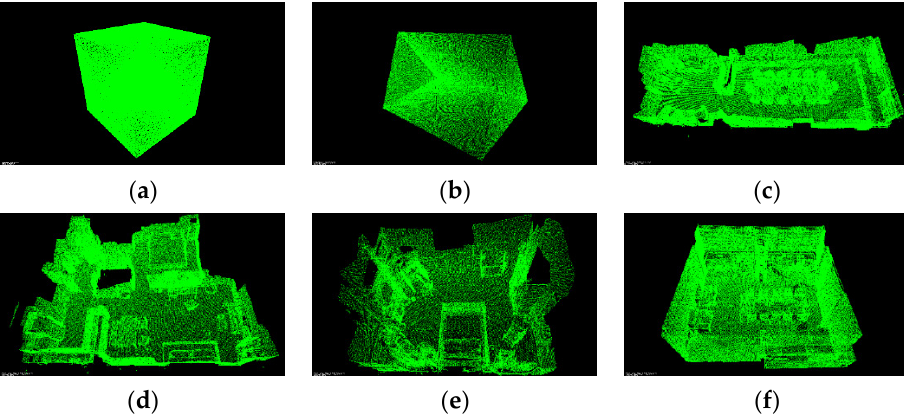
Figure 17. Experimental datasets: ( a ) simulation dataset 1, ( b ) simulation dataset 2, ( c ) real dataset 1, ( d ) real dataset 2, ( e ) real dataset 3, and ( f ) real dataset 4.